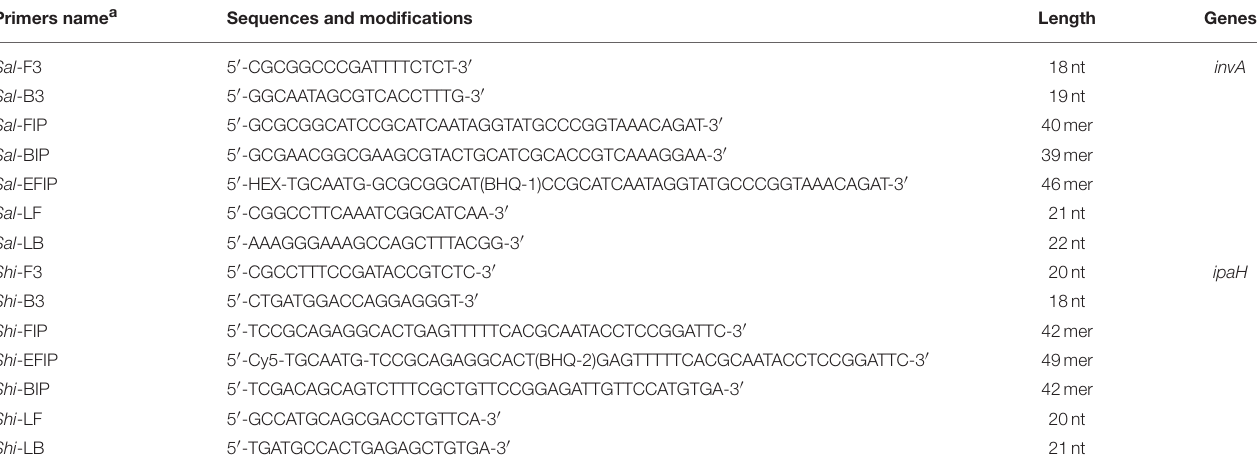
TABLE 1 | The primers used in this study.